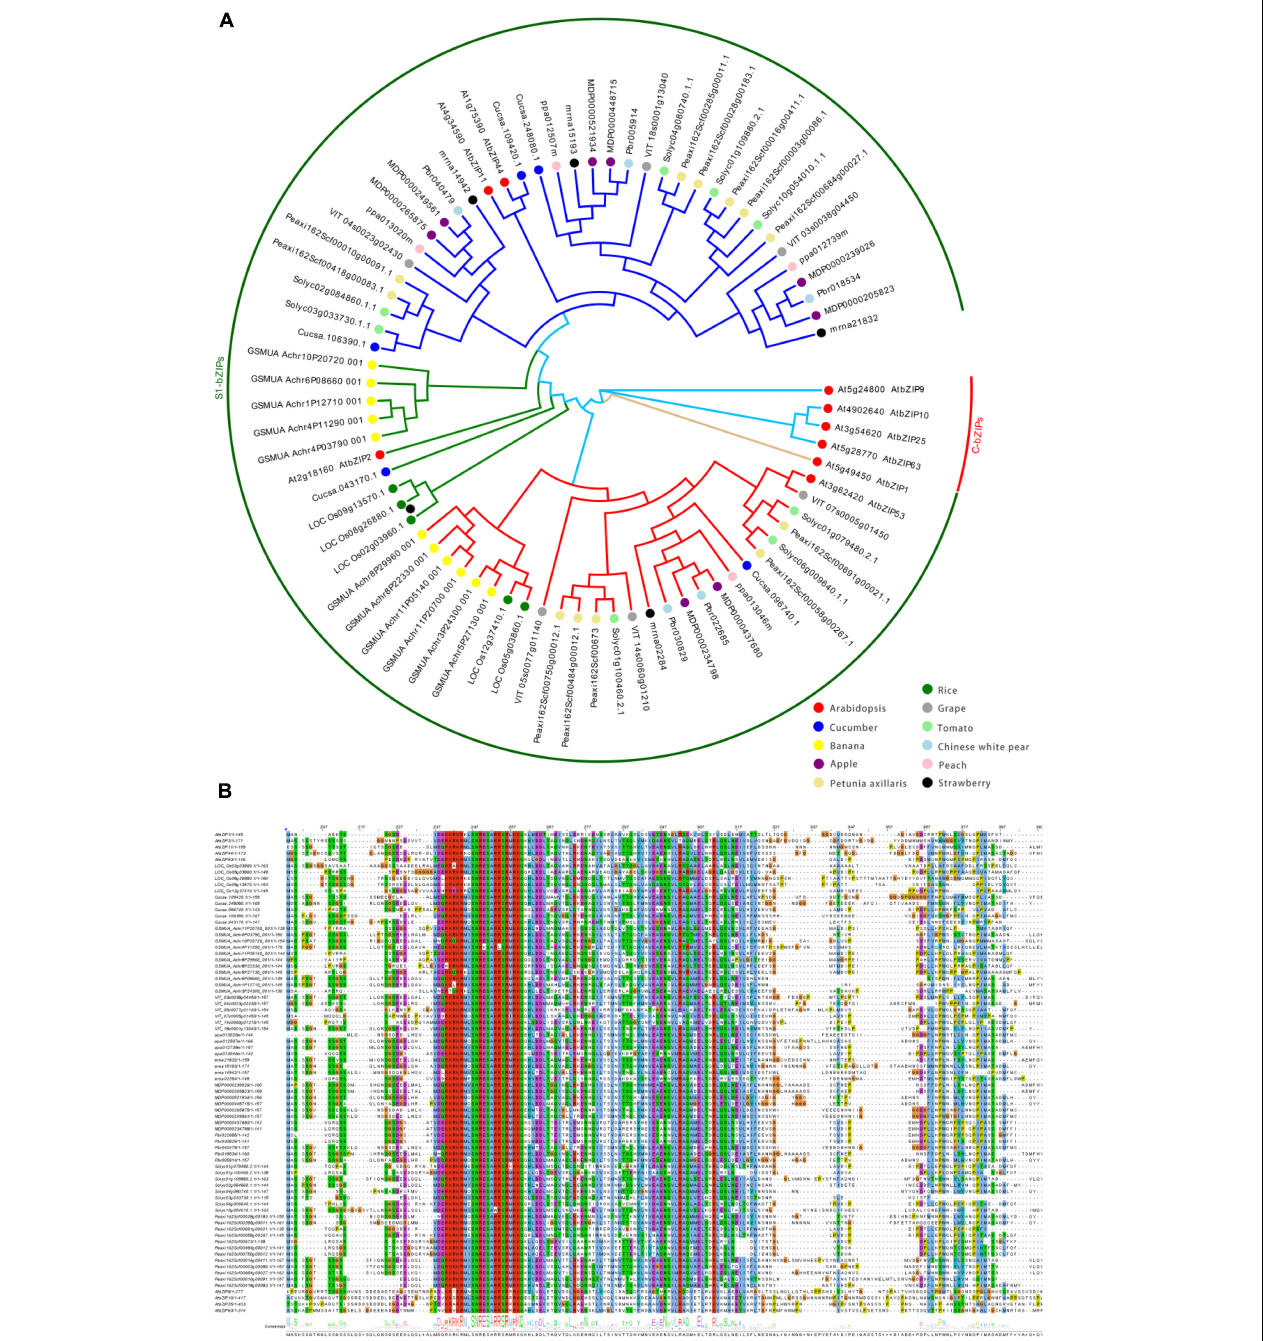
FIGURE 1 | Phylogenetic analysis of S1-bZIPs in some species. (A) The phylogenetic tree was constructed by the neighbor-joining method (NJ) using MEGAx software. The phylogenetic trees were drawn with EvoView at the following URL: https://www.evolgenius.info/evolview/. Colored dots represent members from various species. The proteins were classified into six different clades. Each clade was assigned a different color according to their inclusion of each Arabidopsis S1-bZIP member. (B) The predicted amino acid sequences encoded by the Arabidopsis S1 and C group bZIP mORFs are aligned with the S1 homologs from other species using the multiple sequence alignment tools of ClustalW (Chenna et al., 2003) and the alignment results were displayed using Jalview (Waterhouse et al., 2009). The addition of the Arabidopsis C-bZIP serves as an outgroup.